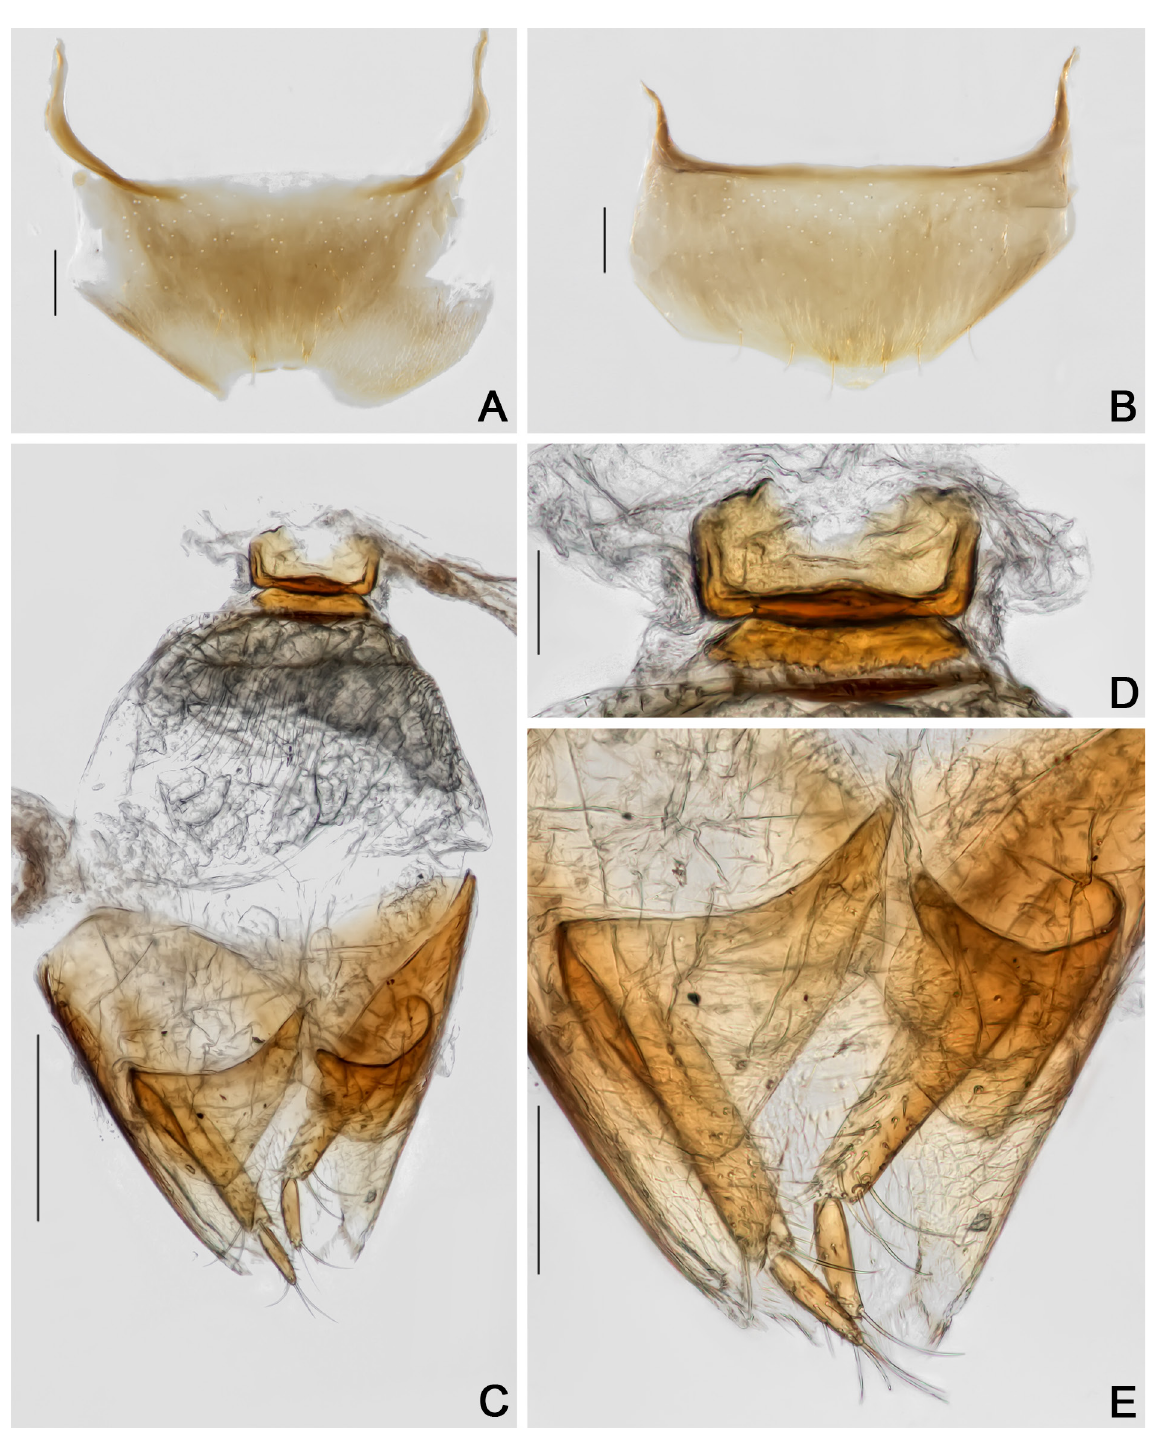
Fig. 37. Cyparium newtoni sp. nov., paratype, ♀ (CELC). A . Tergite VIII. B . Sternite VIII. C . Terminalia. D . Sclerite of vaginal plate. E . Ovipositor. Specimen collected at Mata da Biologia, Viçosa (MG, Brazil). Scale bars: A–B, E = 0.1 mm; C = 0.2 mm; D = 0.05